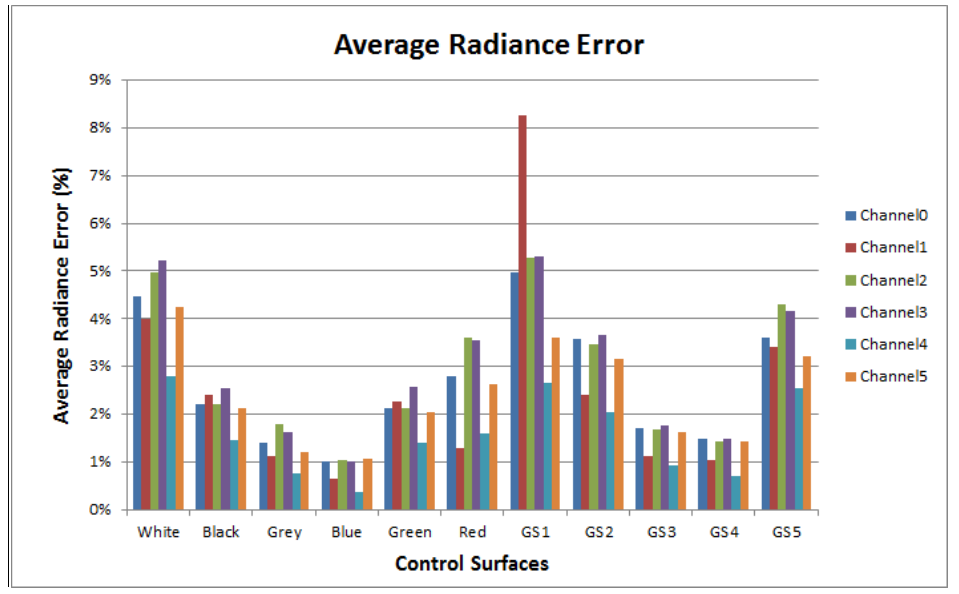
Figure 12. Average radiance calibration error